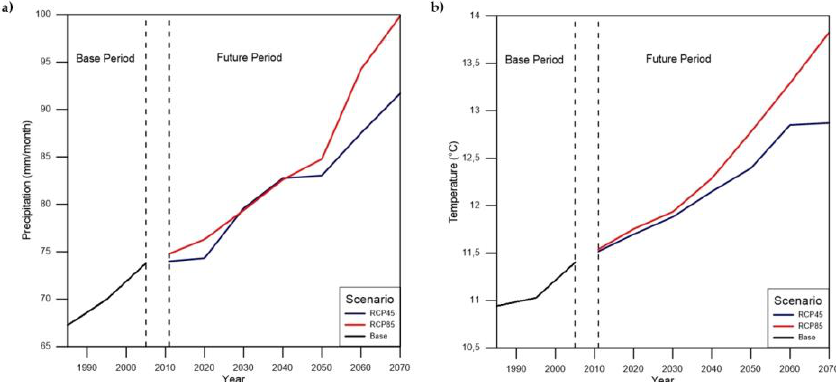
Figure 3. Variation in the base period and future periods of a ) Precipitation; b ) Temperature.